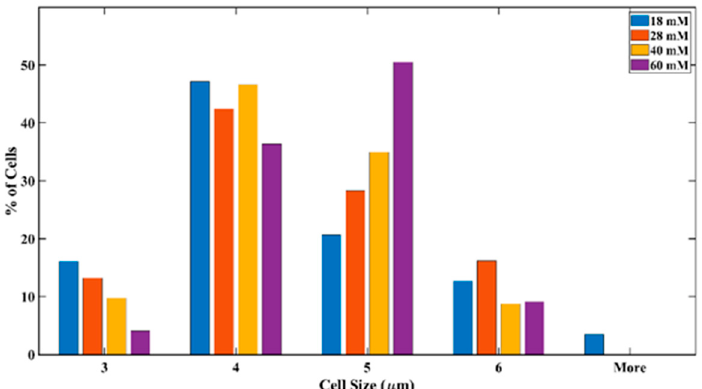
Figure 3. Cell size distribution for different concentrations of inorganic carbon, as sodium bicarbonate: blue bars: 18 mM, orange bars: 28 mM, yellow bars: 40 mM, violet bars: 60 mM.